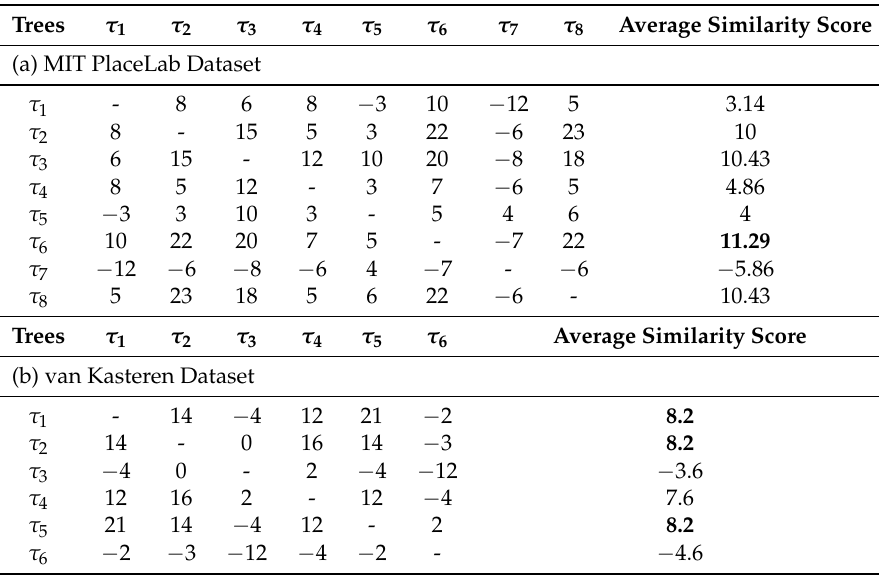
Table 2. Results of the proposed method based on tree